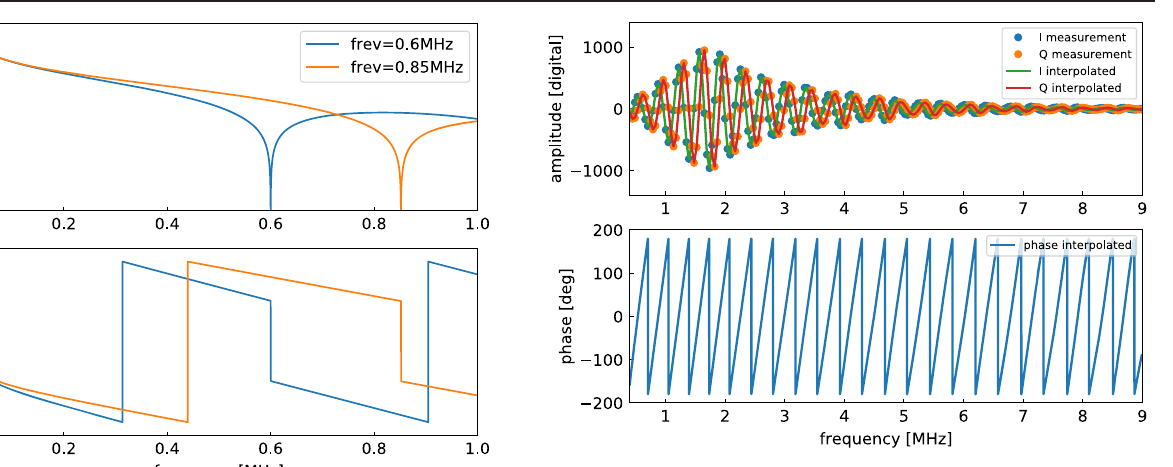
FIG. 15. (Top) The measured I and Q at the 200 points and the interpolated ones and (bottom) the phase response calculated from the interpolated I and Q , when the phase offset LUT is set to zero for all